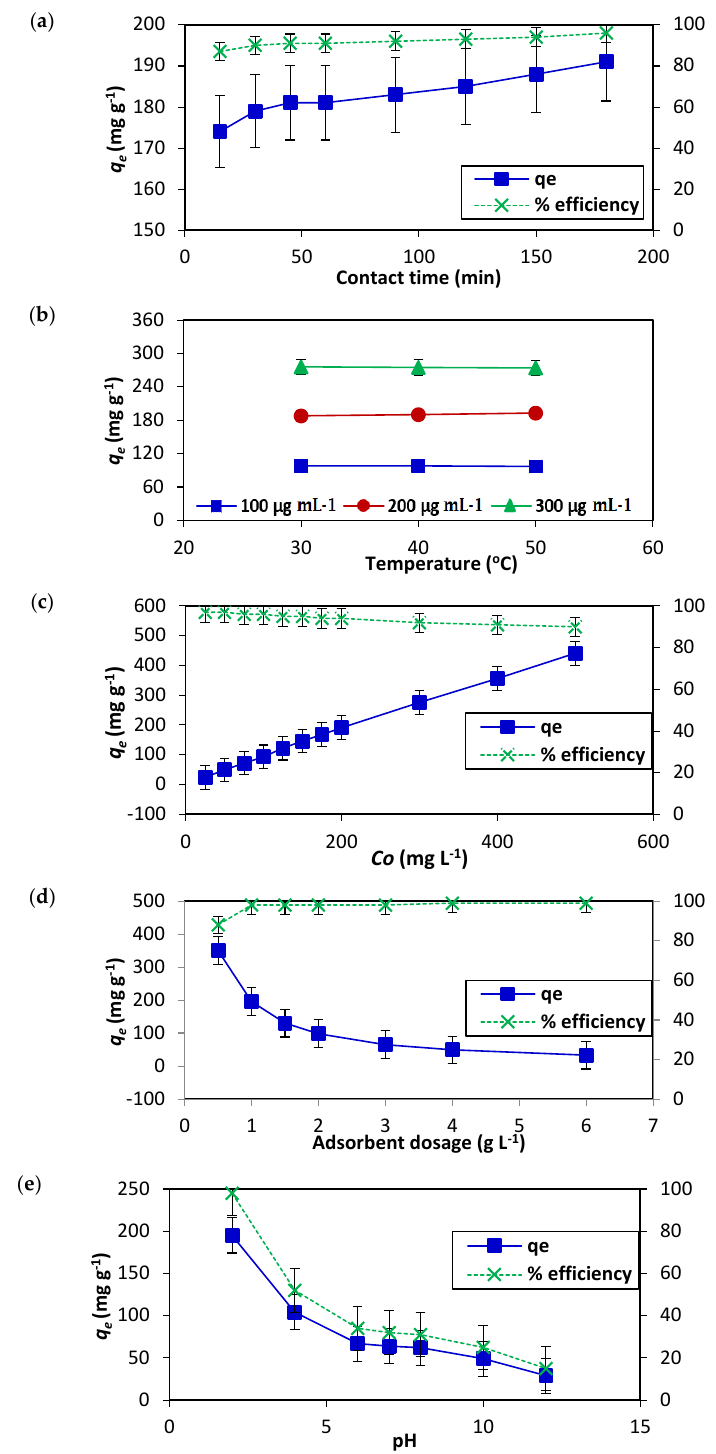
Figure 7. Effect of ( a ) contact time, ( b ) temperature, ( c ) initial dye concentration, ( d ) dosage and ( e ) pH on q e and percent removal efficiency of the AR119 – NICUS system.